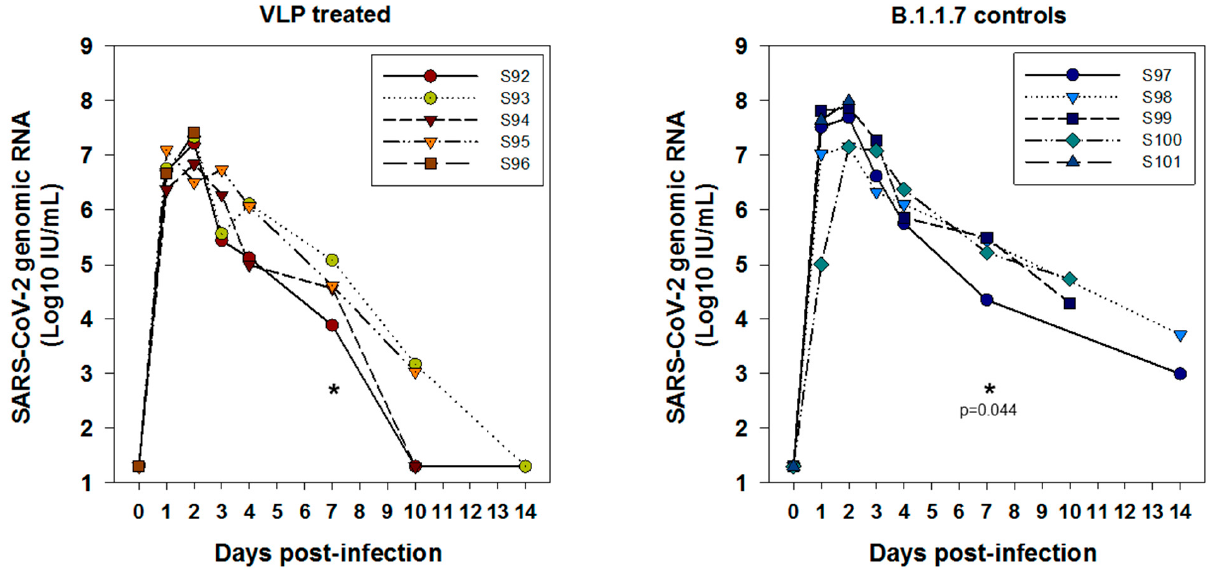
Figure 7. Viral genomic RNA kinetics in oral swabs demonstrating slower clearance of gRNA in oral swabs in controls compared to VLP treatment group. One-tailed t-test at day 4; p = 0.16 (ns); day 7, statistically significant p = 0.044 (indicated). Comparison of 2 day (peak) virus load in oral swabs was 1.4 × 10 7 for the treatment peak compared to 4.7 × 10 7 for the B.1.1.7 control (i.e., approximately half a log difference). It was non-significant by Mann-Whitney Rank Sum test (* p = 0.421).